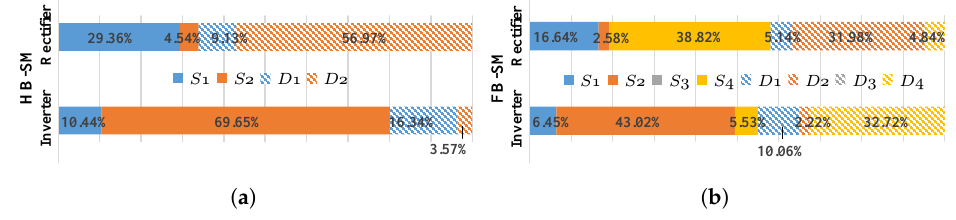
Figure 23. Loss distribution amongst SM devices: ( a ) HBSM and ( b )